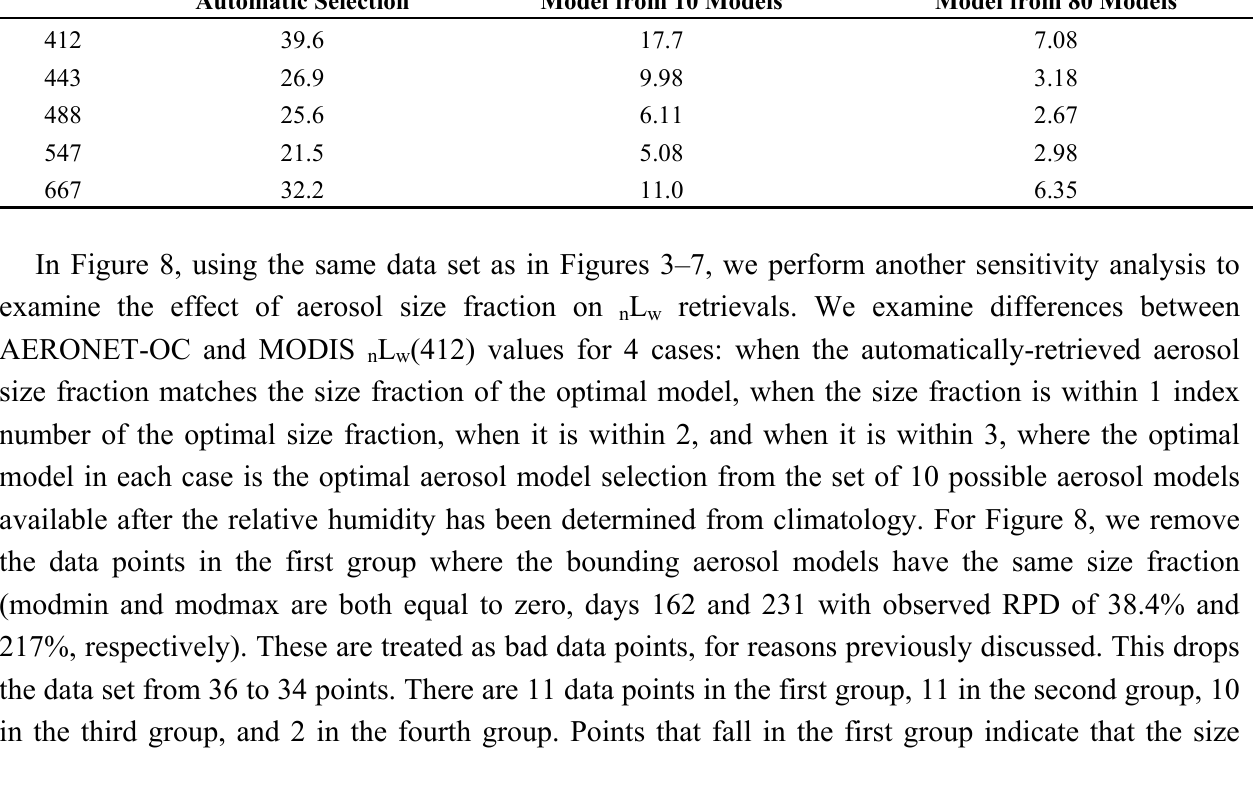
L ( λ ) values, Martha’s Vineyard, 2010. n w